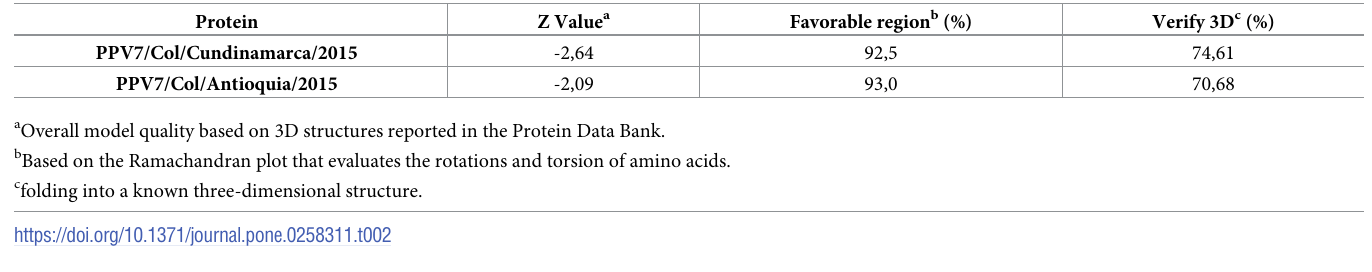
Fig 1. ML-method phylogenetic tree based on PPV7-VP2 nucleotide sequences. The phylogenetic tree with the highest log likelihood is exhibited. The analysis involved 58 nucleotide sequences and a total of 1369 positions in the final dataset. Groups are differentiated for the presence or absence of the five aa insertion.